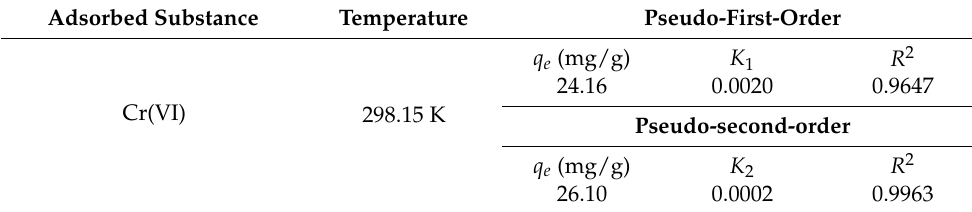
Table 1. Parameters of the adsorption kinetics